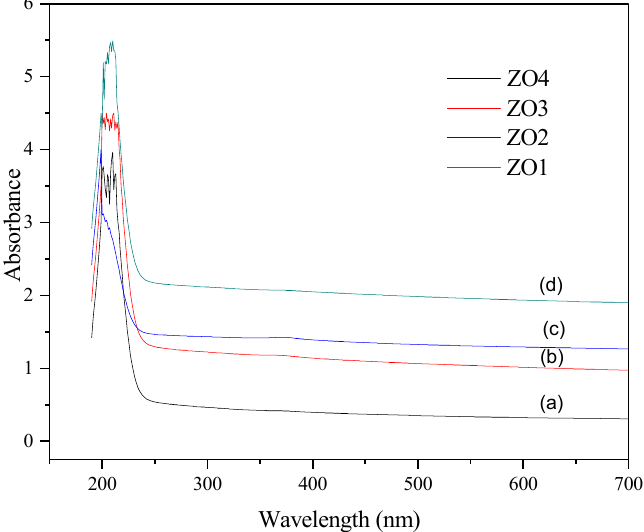
Fig. 4. UV-Vis absorption spectrum for ZrNPS (a) ZO1 (b) ZO2 (c) ZO3 and (d) ZO4